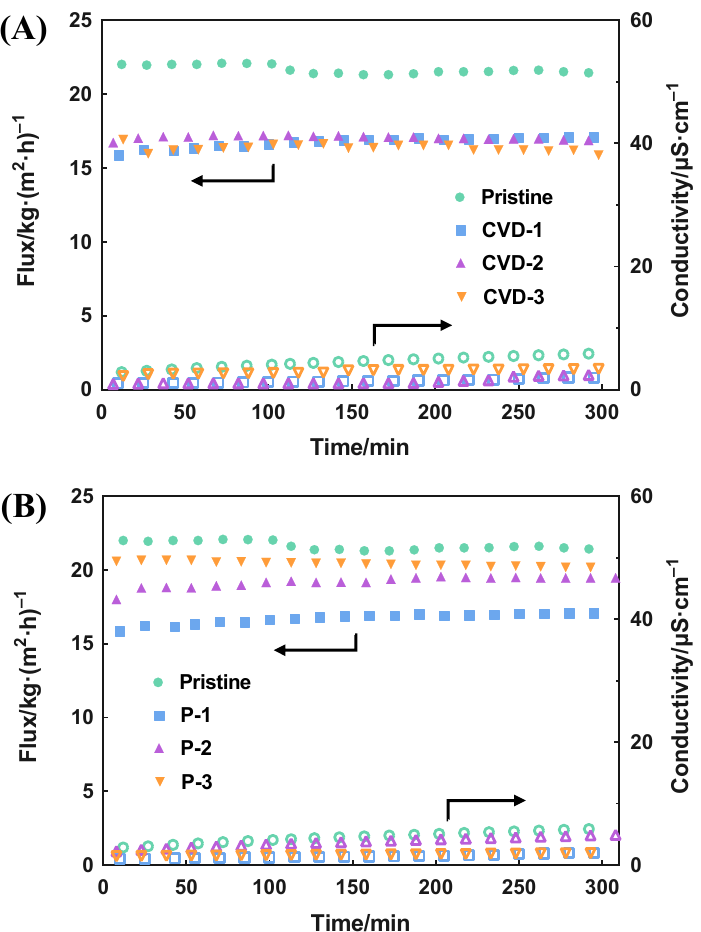
Figure 3. The MD performance of different modified times of ( A ) CVD and ( B ) P-C treatment (feed solution: 35 g·L − 1 NaCl).